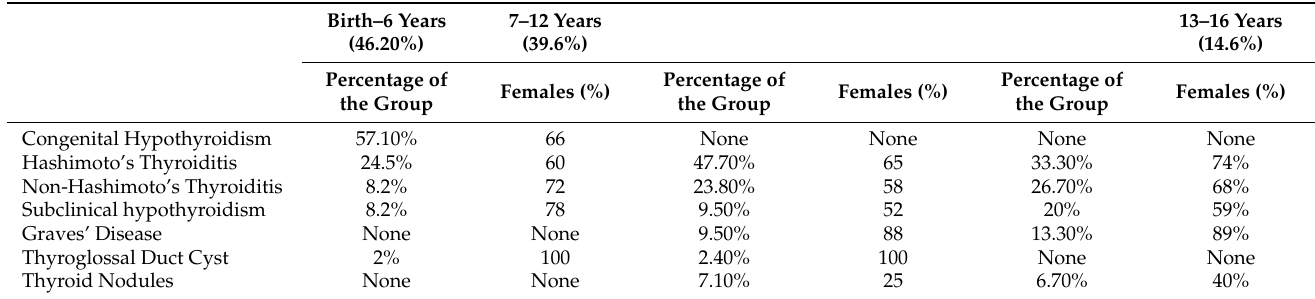
Table 2. Age group and gender distribution of thyroid